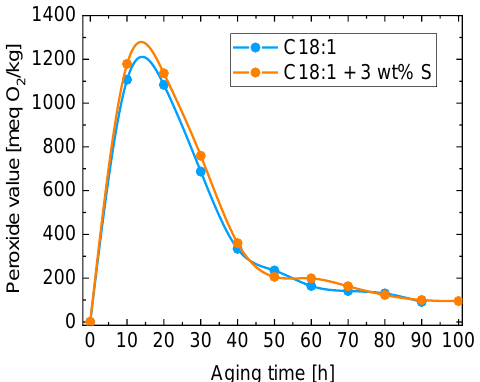
Figure 7 . Determination of first measurement peroxide values over time (0–100 h) according to wheeler. The blue line describes the pure C18:1 and the orange line the C18:1 + 3 wt% S.